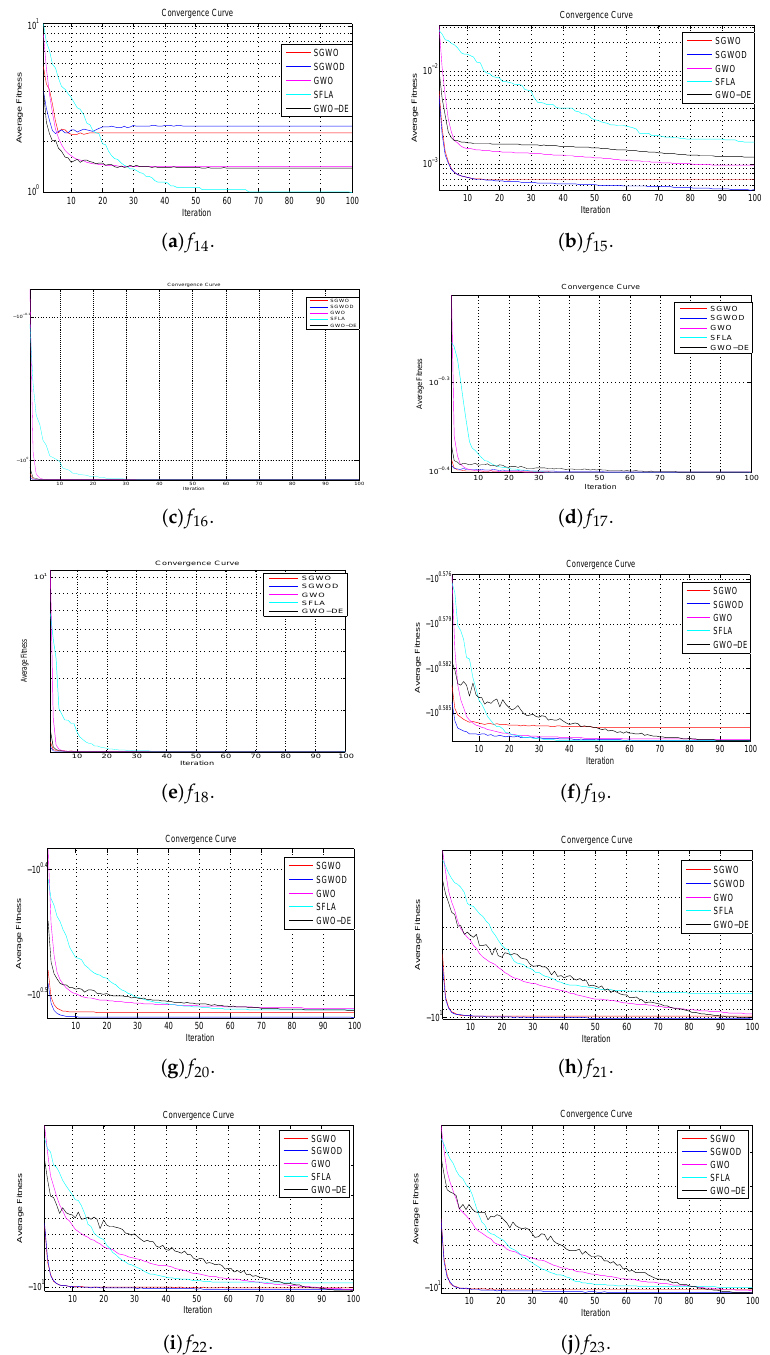
Figure 8. Convergence curves of fixed-dimension multimodal benchmark